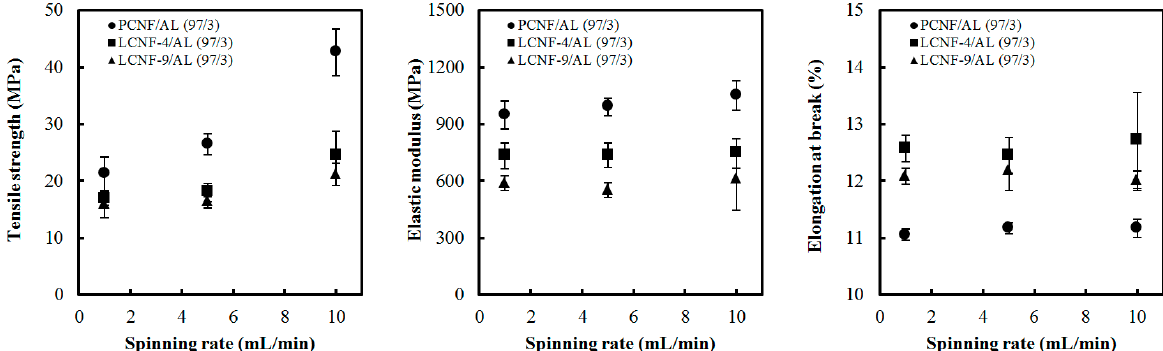
Figure 9. Tensile strength, elastic modulus, and elongation at break of wet-spun composite filaments from PCNF/AL, LCNF-4/AL, and LCNF-9/AL with a CNF/AL ratio of 97/3 at different spinning rates. Polymers 2021 , x, x FOR PEER REVIEW